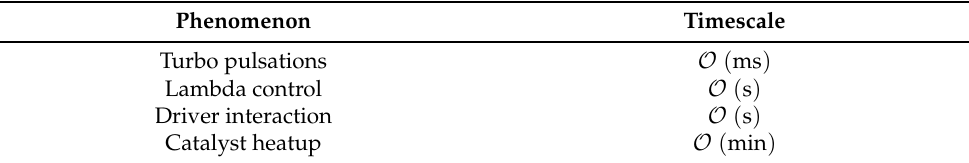
Table 1. Timescales in automotive